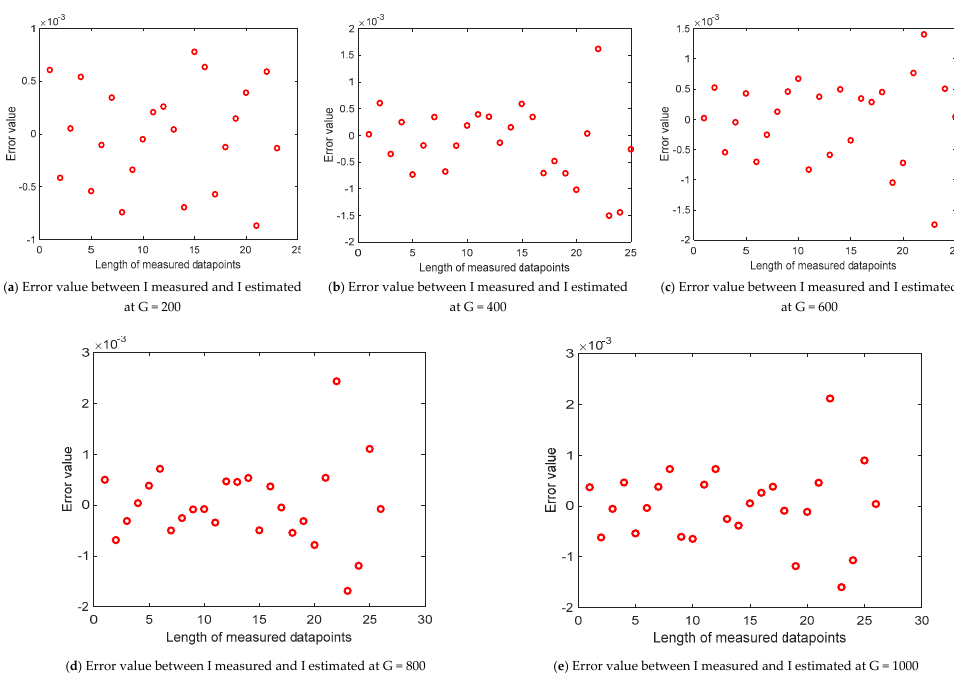
Figure 26. Depiction of error value between all I measured and estimated data on the ST40 module at different irradiance.